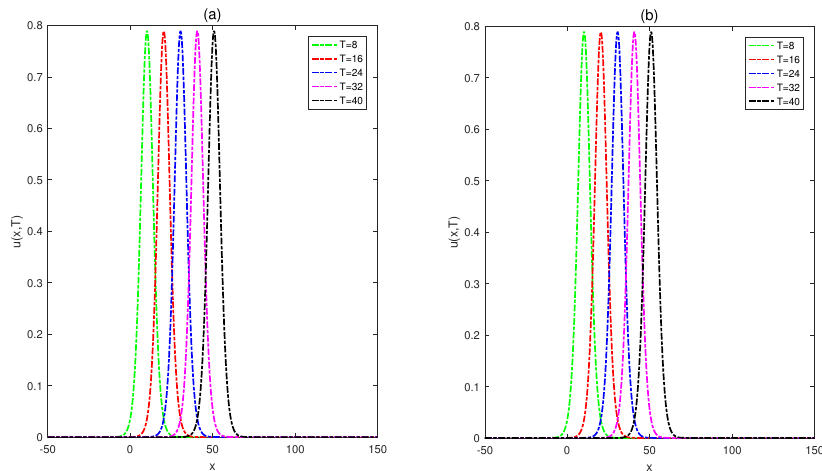
Figure 11. Motion of the single solitary wave with h = τ = 0.4 ( a ) and h = τ = 0.2 ( b ) over the interval x ∈ [ − 50,150 ] at final times T ∈ { 8,16,24,32 } for Example 4.